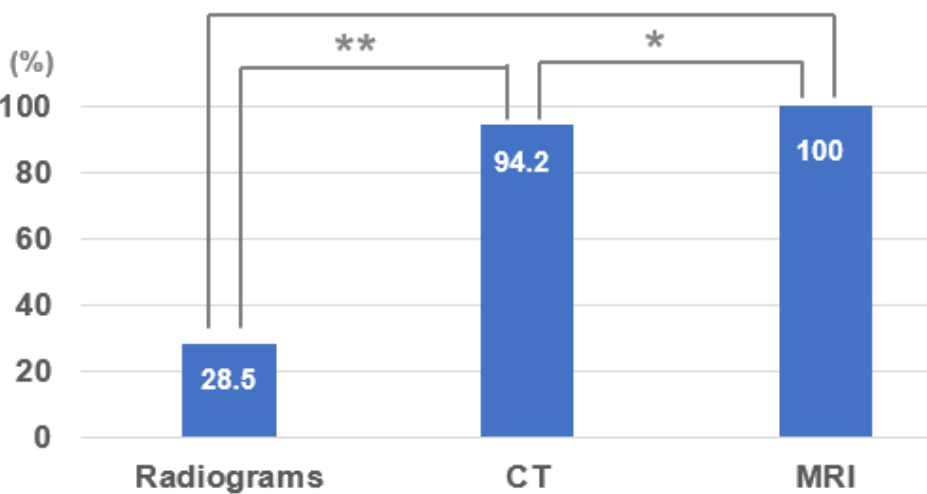
Figure 4. SIF diagnosis sensitivity of three modalities; * p < 0.05, ** p < 0.01. CT: computed tomography, MRI: magnetic resonance imaging.